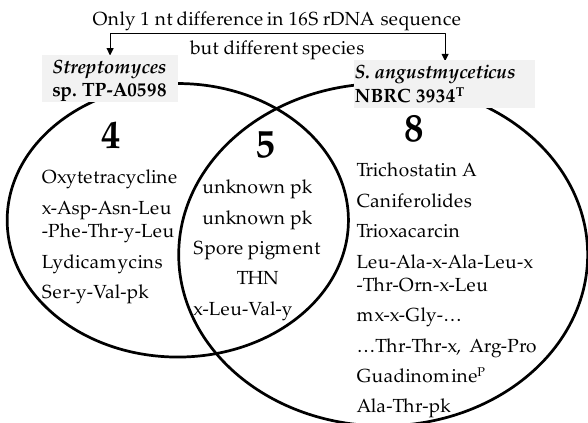
Figure 2. Venn diagram showing the putative compounds derived from PKS and NRPS pathways of phylogenetically close Streptomyces sp. TP-A0598 and Streptomyces angustmyceticus NBRC 3934 T . Five are conserved between the two strains, whereas four and eight are specific to Streptomyces sp. TP-A0598 and S. angustmyceticus NBRC 3934 T , respectively. pk, moiety derived from PKS pathway; THN, tetrahydroxynaphthalene; x, unidentified amino acid; y, unknown building block; mx, methyl-amino acid; P , partial.